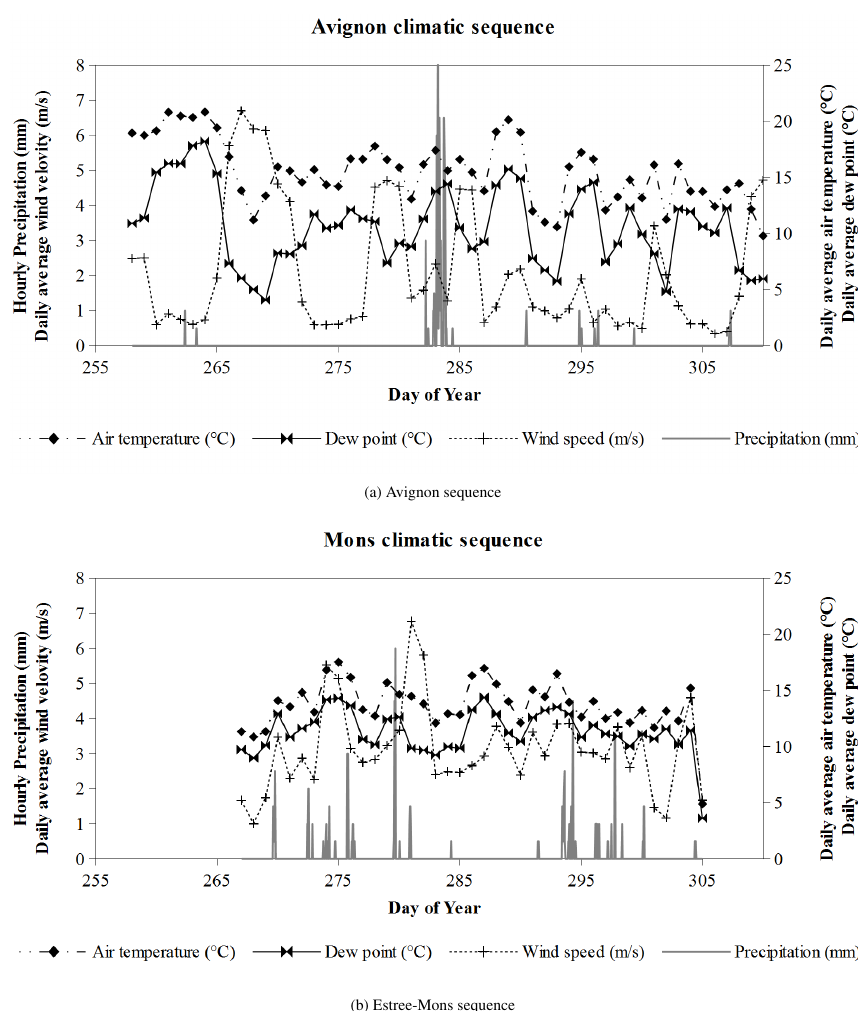
Figure 2. Climate forcing: precipitation, air temperature, dew point and wind velocity at 2m